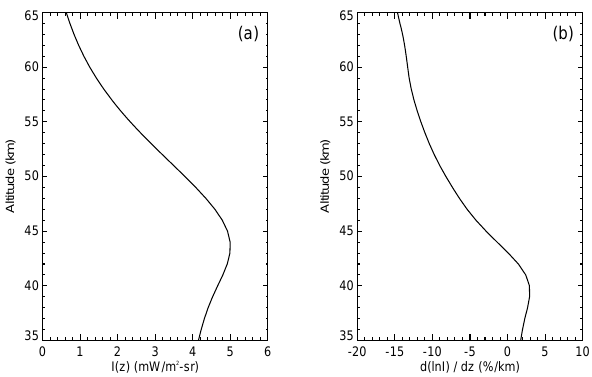
Figure 4. (a) shows GSLS-model-calculated 305nm radiances as a function of altitude assuming an atmosphere with no aerosols. The slope (b) is caused by competition between Rayleigh scatter- ing and ozone absorption near the altitude of maximum radiance, ∼ 44km. Above 55km the sensitivity is nearly constant in height, ∼ 14%km − 1 at 65km. Above the knee the radiances decrease with altitude due to the exponential decrease in Rayleigh scattering and ozone density. Below the knee the ozone absorption becomes so large that it essentially blocks most of the Rayleigh-scattered radia- tion from reaching the satellite, making the radiances insensitive to atmospheric pressure. This characteristic knee shape allows one to estimate altitude registration error in a manner very similar to that of RSAS, but it also makes it is very susceptible to ozone profile assumptions, as illustrated in Fig.